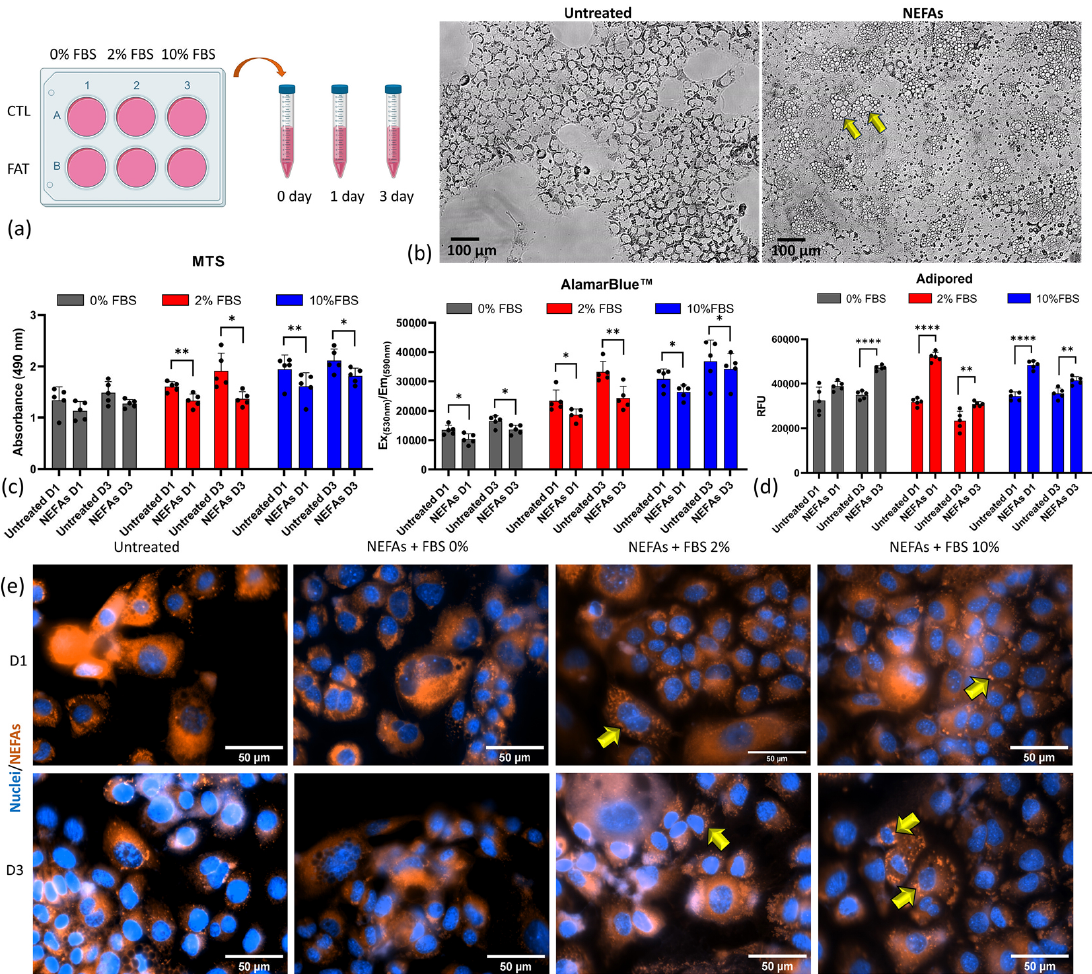
Figure 2. In vitro model of fatty hepatocytes. ( a ) experimental setup. ( b ) Bright microscopy of mouse hepatocytes with and without treatment with non-esterified fatty acids. ( c ) Cell viability and metabolism of hepatocytes treated with 400 µ M of NEFAs up to three days; * p ≤ 0.05; ** p ≤ 0.01; *** p ≤ 0.001; **** p ≤ 0.0001. ( d ) Quantitative and ( e ) qualitative intracellular fat accumulation using Adipored ™ assay. Yellow arrows indicate the lipid droplets accumulated inside the cells, especially around the